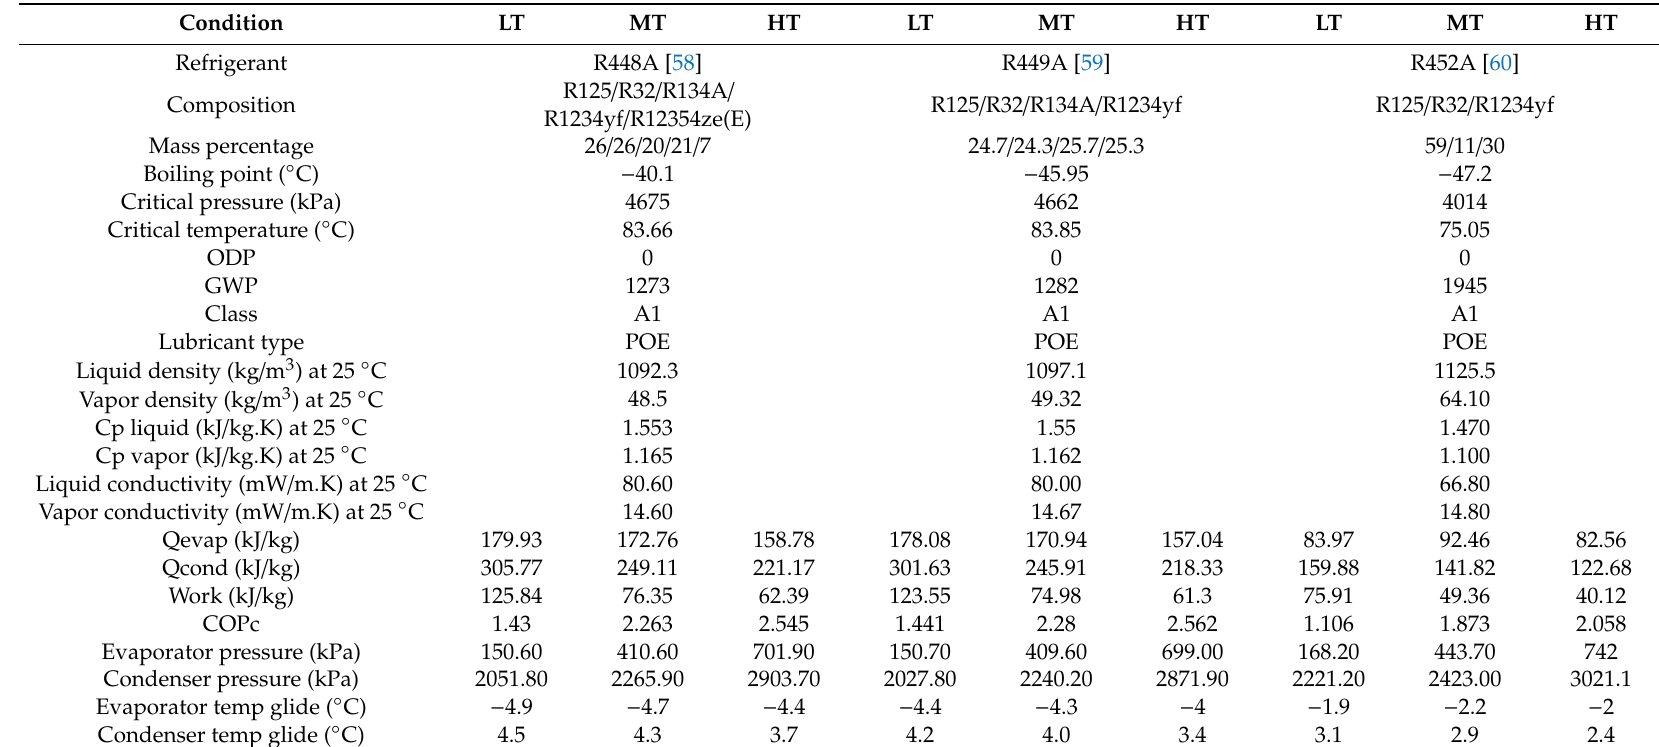
Table 7. Properties of R448A, R449A, and